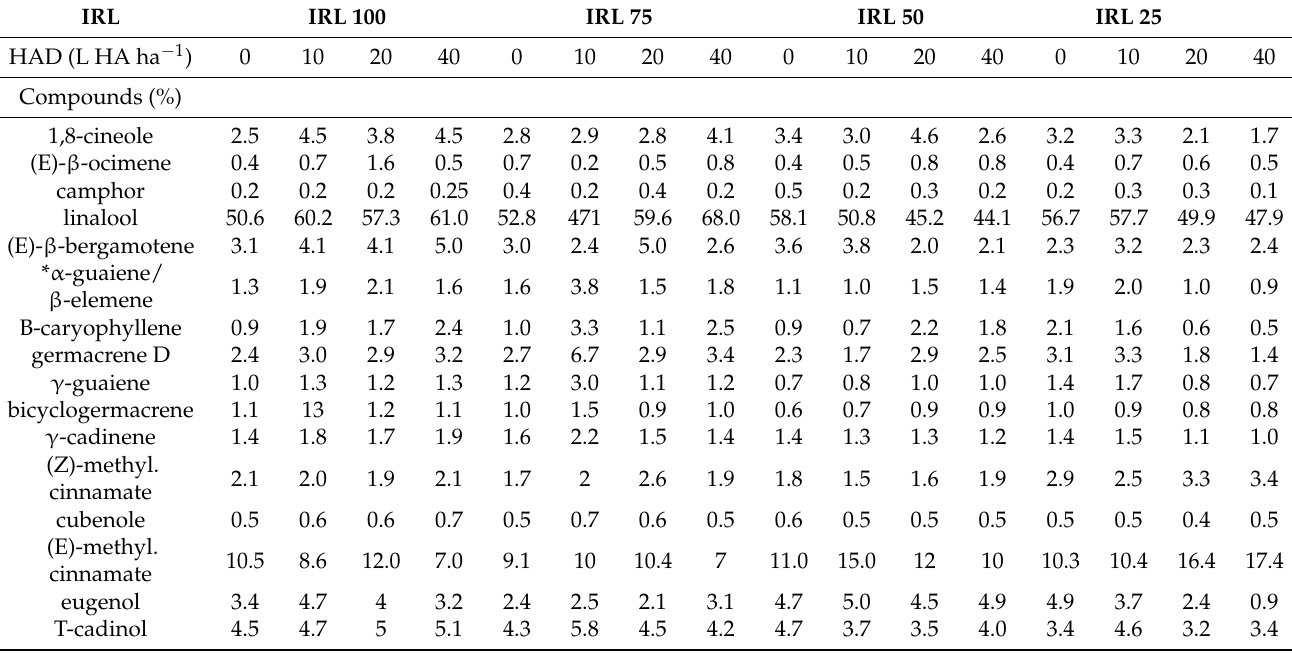
Table 7. Essential oil components of O. basilicum L. according to different IRLs and HADs under control conditions.